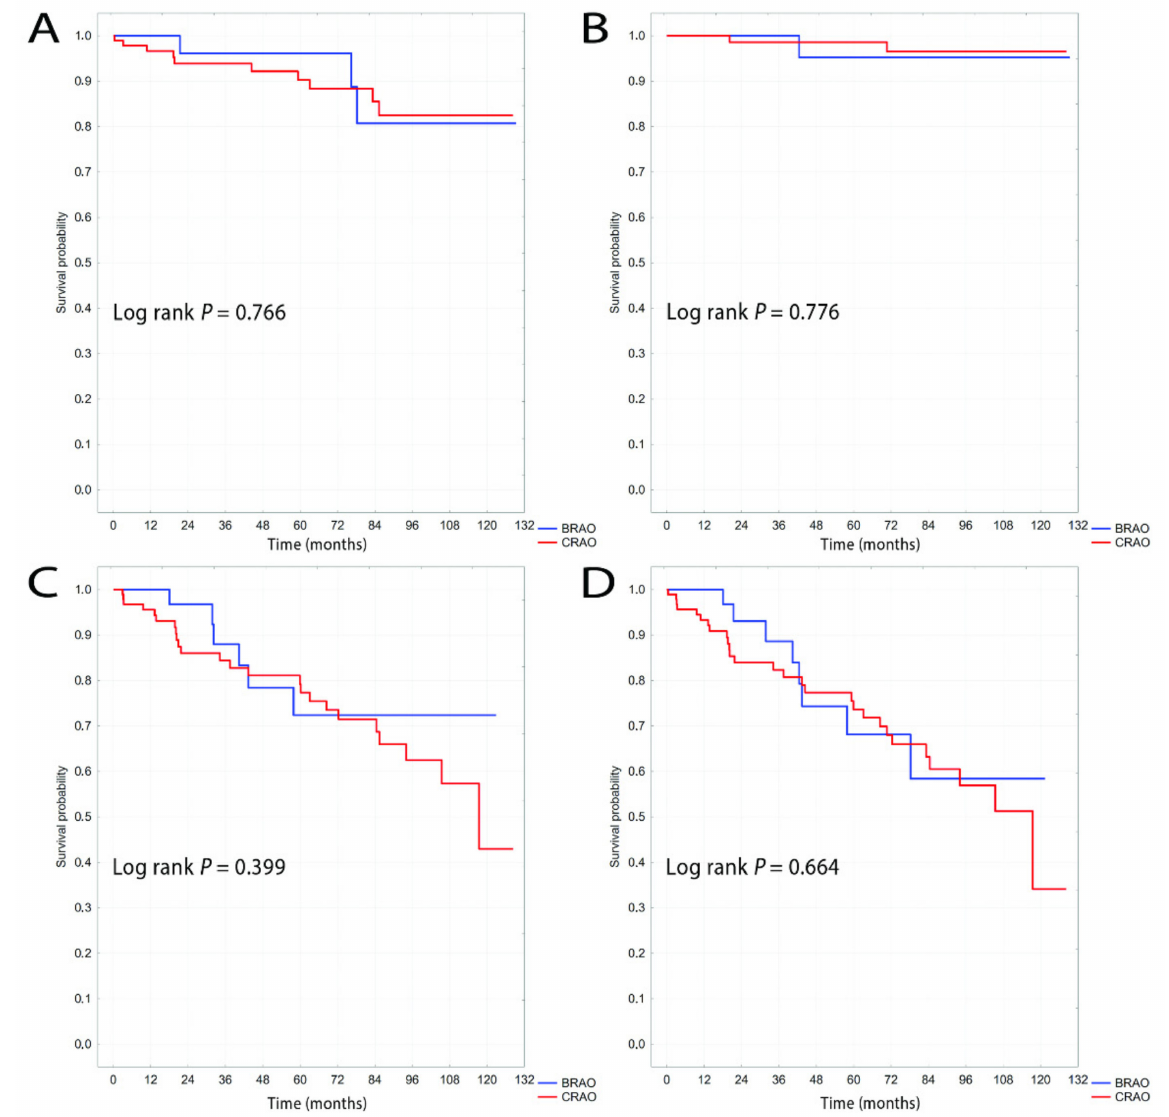
Figure 2. Kaplan-Meier curves of survival probability for entire study population for ischemic stroke ( A ), myocardial infarction ( B ), all-cause mortality ( C ) and the composite endpoint ( D